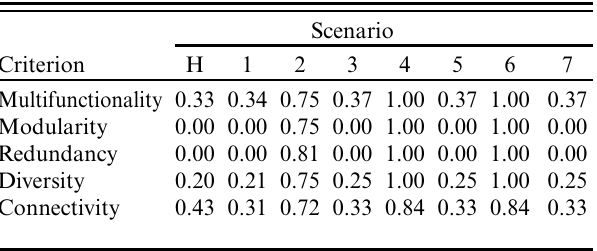
Table 5 . Socio-technical capacity criteria scores following historic development (H) and future urban development Scenarios 1 to 7, Lucas Creek